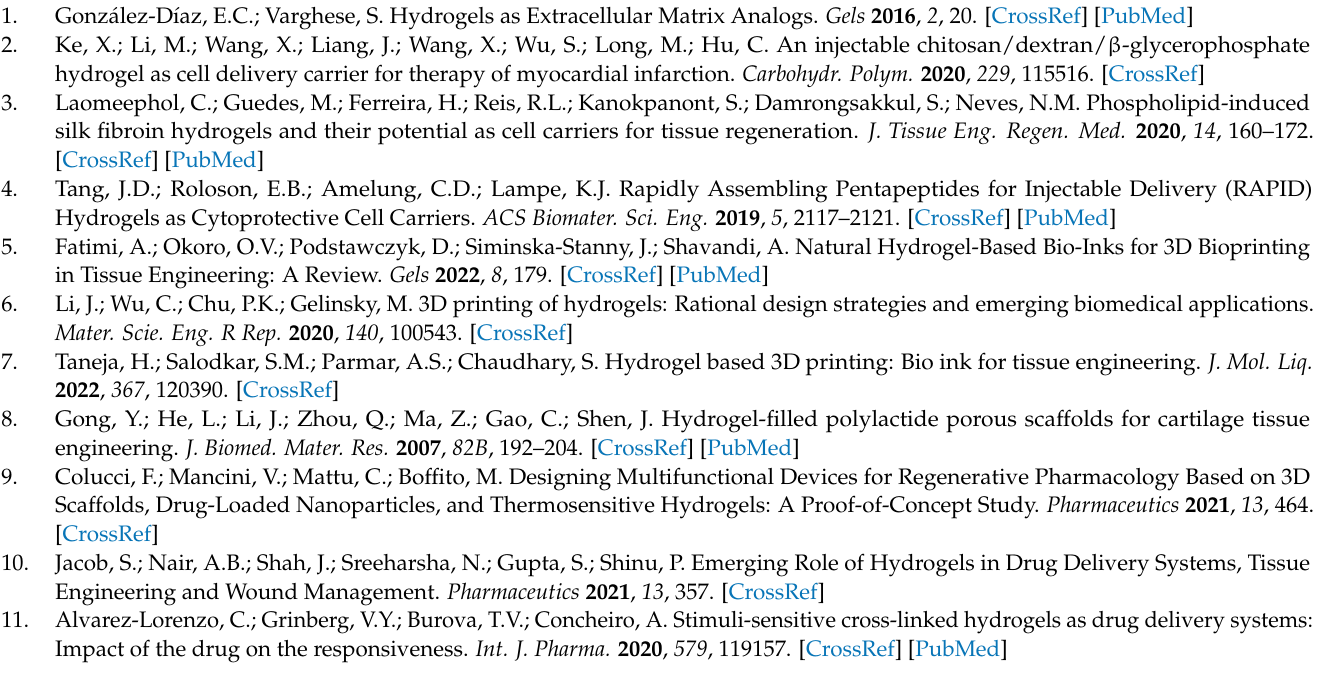
Figure S4: Rheological assessment of the role exerted by the co-initiator in the thiol-ene photo- crosslinking